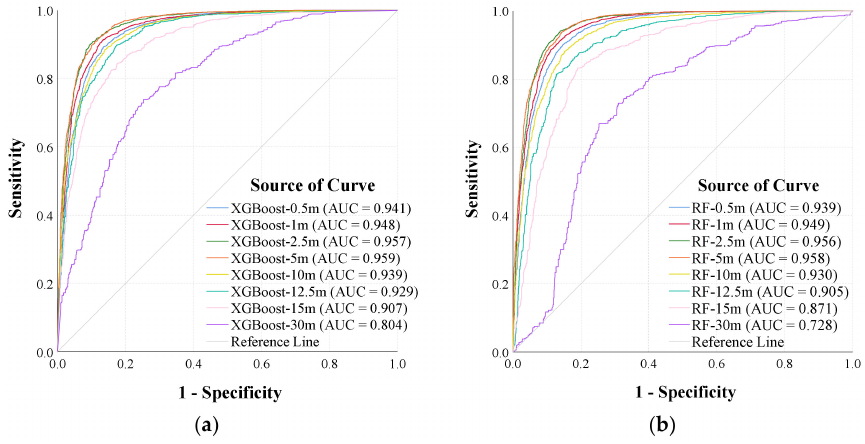
Figure 5. Validation of the ROC curve at each resolution. ( a ) XGBoost. ( b ) RF.